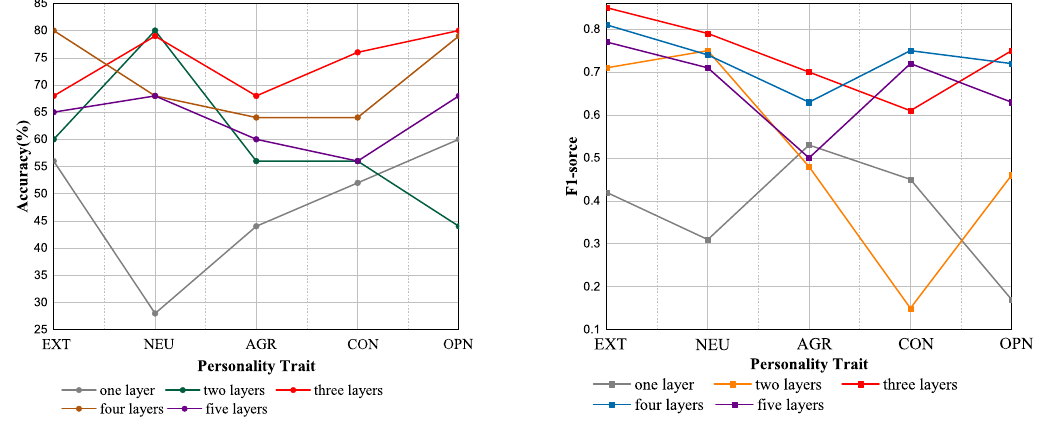
Figure 4. Accuracy and F1-score in the myPersonality dataset with different numbers of personality GCN layers.